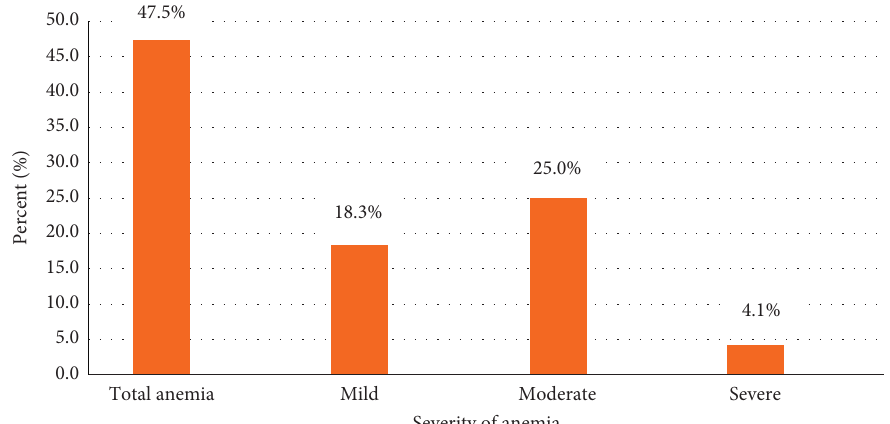
Figure 2: Prevalence and severity of anemia among infant and young children aged 6–23 months in Debre Berhan Town, North Shewa, Zone, Ethiopia,